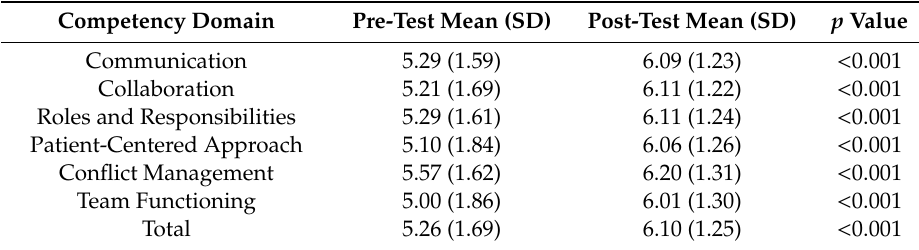
Table 2. Interprofessional collaborative competency attainment survey (ICCAS) results from completed pre- and post-test surveys ( n = 386).